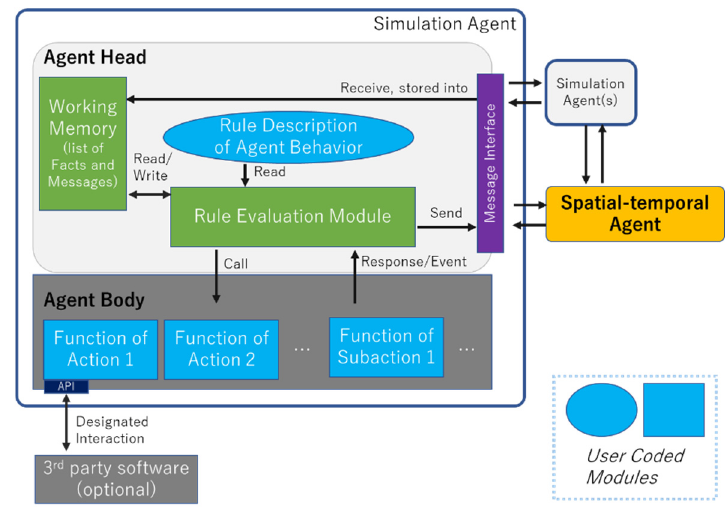
Figure 2. Self-contained architecture of agent in proposed simulation environment.